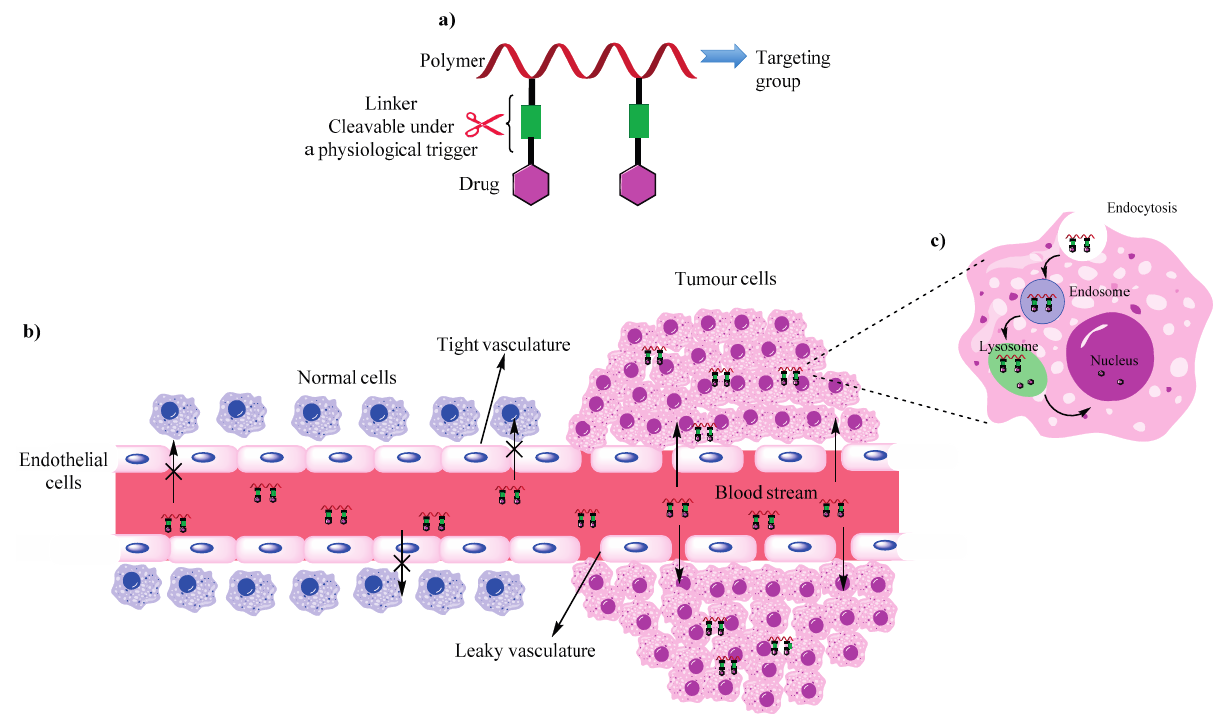
Figure 1. ( a ) Schematic representation of a polymer-drug conjugate (PDC); ( b ) EPR effect facilitating passive tumour targeting of PDCs; and ( c ) Lysosomotropic delivery of